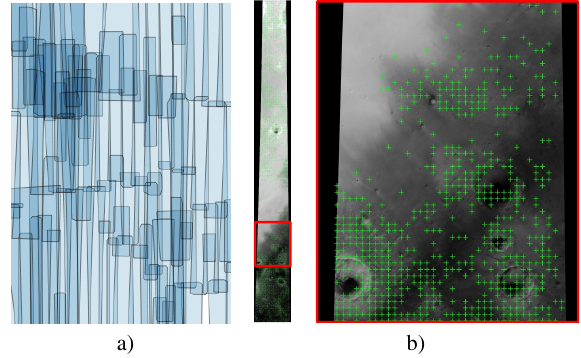
Figure 2: a) HRSC image strips in MC-11-E; b) tie points in HRSC image h1183 0000; both showing a irregular, heterogeneous distribution image texture. However, because the bundle adjustment uses the DTM derived from the Mars Orbiter Laser Altimeter (MOLA) as reference, a homogenous distribution of the tie points is prefer- able (Spiegel, 2007). For a systematic processing of these large 1 Mean forward intersection error per strip. Referring to image rays, used to calculate object points after bundle adjustment of individual